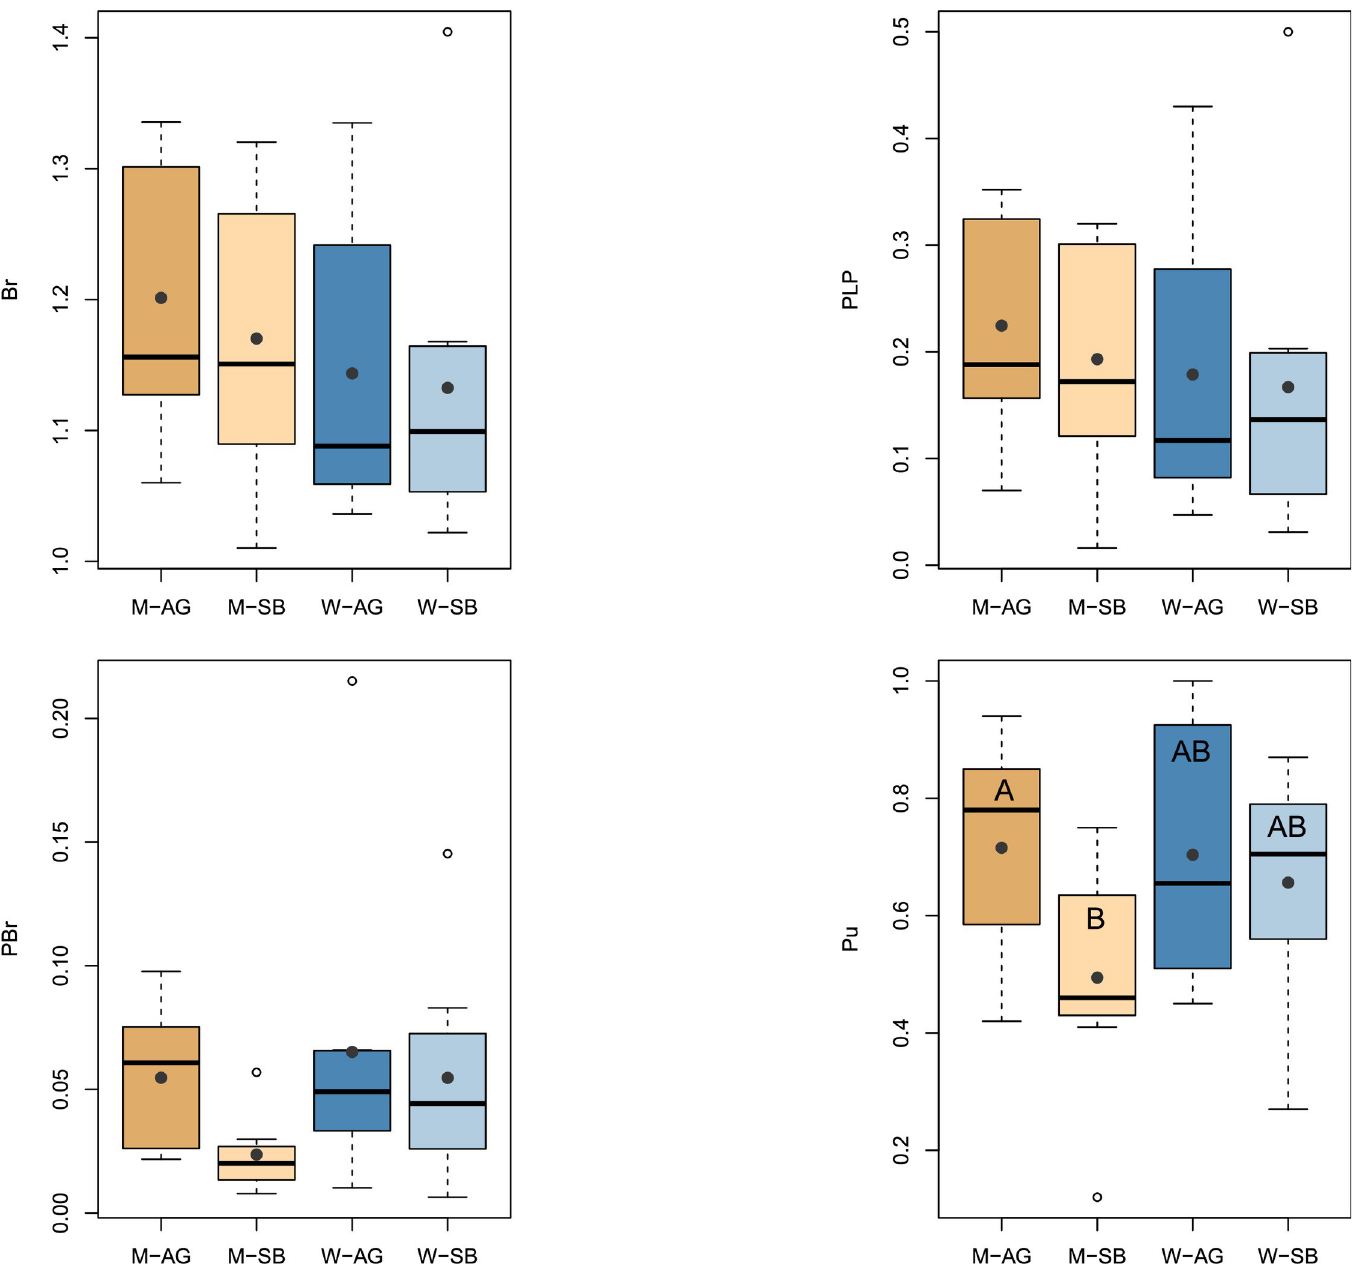
Fig 1. Diversity measures of Viola elatior for aboveground and seed bank cohorts in meadow (M) and woodland (W) habitats, respectively. Br = band richness, PLP 5% = percentage of polymorphic loci at the 5% level; PBr = private band richness (aboveground vs. seed bank); P u = proportion of unique AFLP-phenotypes. Grey diamonds depict arithmetic means.